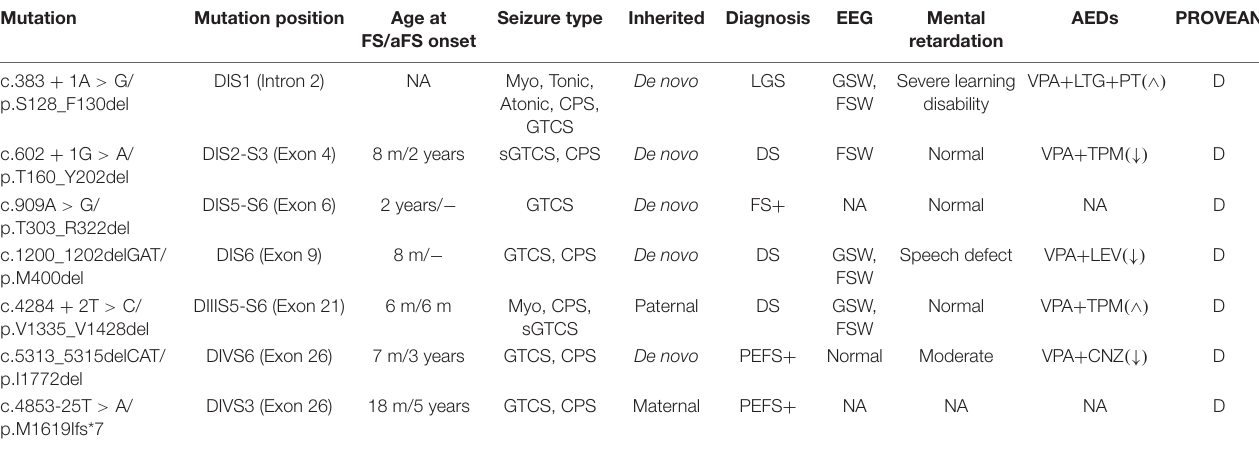
TABLE 1 | Clinical features associated with six identified in-frame deletion and one truncation variants in SCN1A.